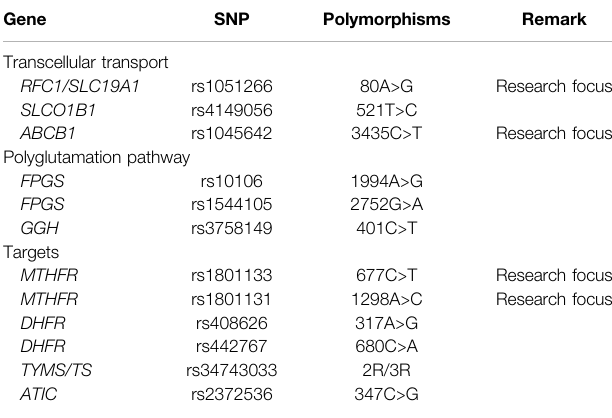
TABLE 1 | Genetic polymorphisms within the HDMTX pathway